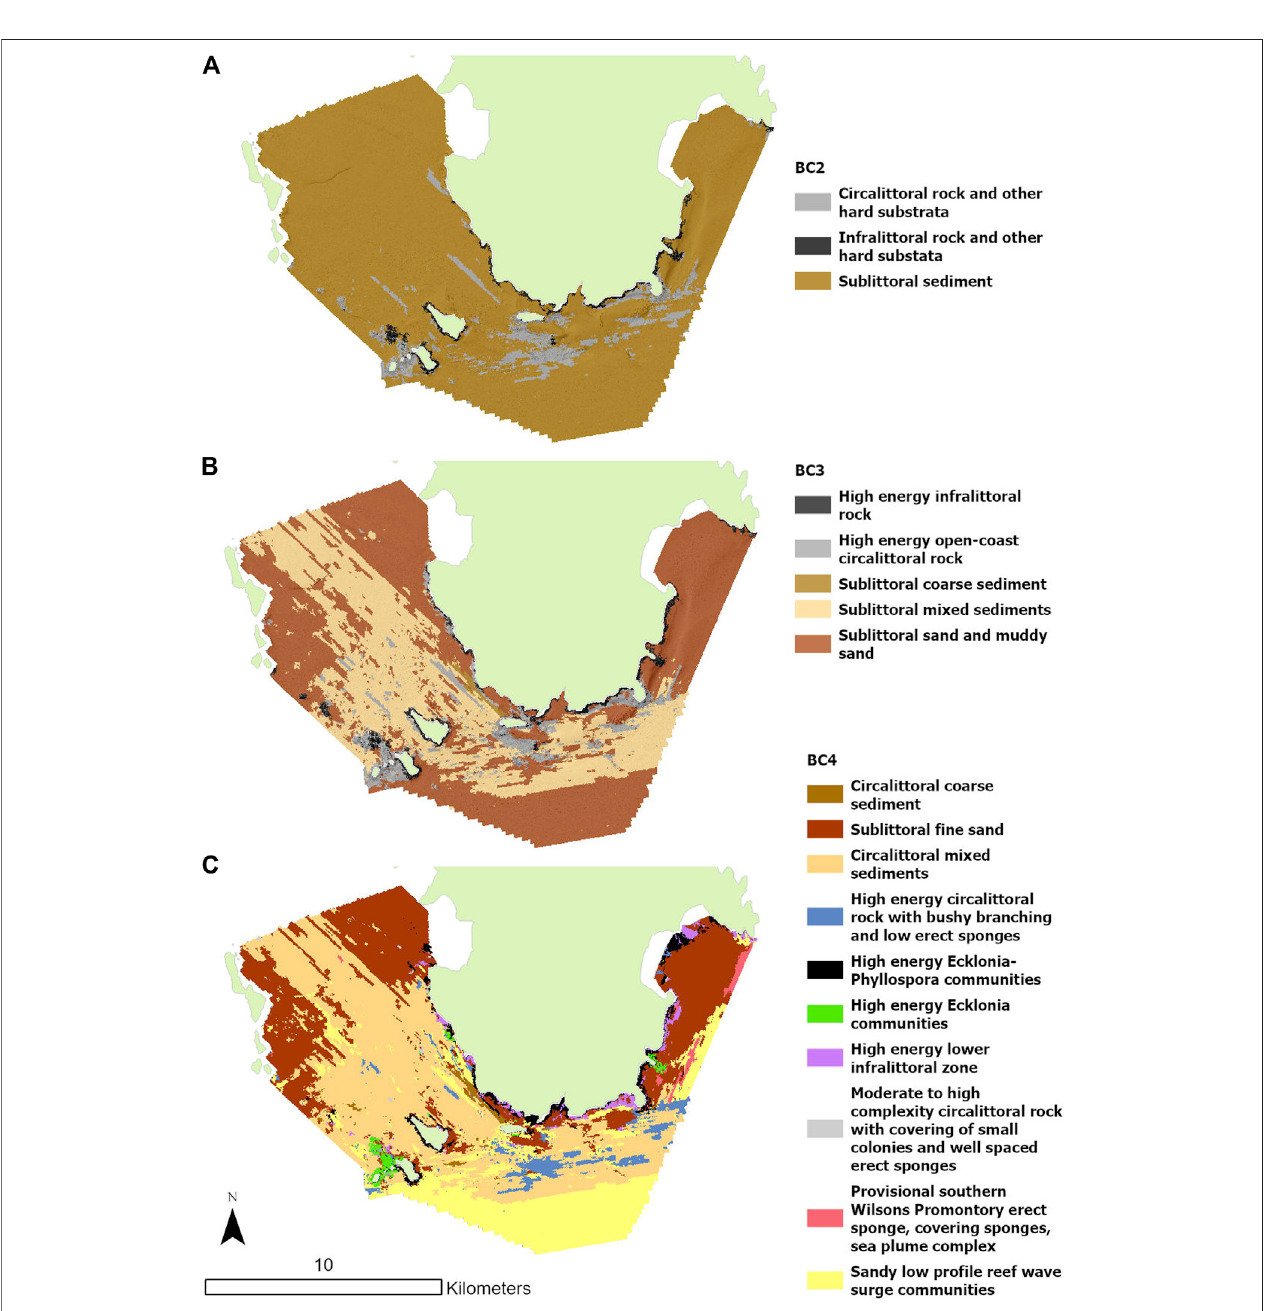
FIGURE7| Habitatclassi fi cationmapsacrossCBiCShierarchiesfor fi nesegmentation. (A) habitatmapforBC2, (B) habitatmapforBC3, (C) habitatmapforBC4. Created using ModelMap in R. Fine image segmentation used for fi nal habitat maps.